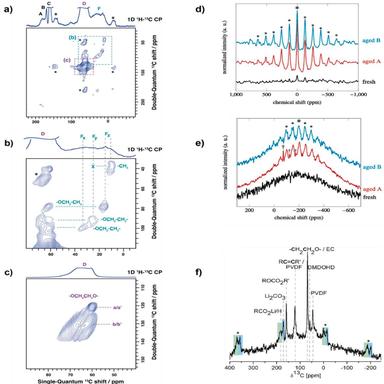
.1. 13C single-quantum/double-quantum (SQ/DQ) homonuclear correlation experiment performed with the 1 H-13C– cross-polarization J-based INADE-QUATE pulse sequence of a Si anode extracted from a Li/Si cell with 13C-labelled EC in the electrolyte. (a) Entire spectrum; (b) and (c) zoomed in regions. Dashed lines are used to show correlations between signals which means those chemical groups are directly bonded to each other; (d) 7 Li and (e) 19F SSNMR spectra of aged LiFePO4 electrodes extracted from cells. a